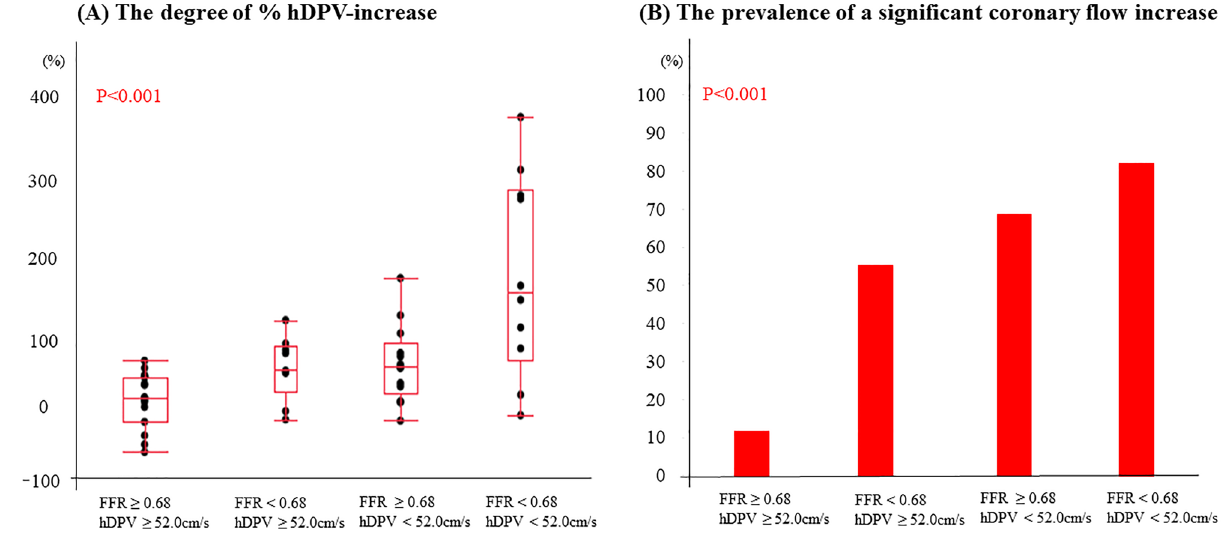
Figure 4. The degree of % hDPV-increase and the prevalence of a significant coronary flow increase in four groups stratified by the best cut-off values of pre-PCI FFR and pre-PCI hDPV (pre-PCI FFR = 0.68 and pre-PCI hDPV = 52.0 cm/s). ( A ) The degree of % hDPV-increase was significantly different between the four groups. ( B ) The prevalence of a significant coronary flow increase was significantly different between the four groups. Abbreviations as in Figs. 1 and